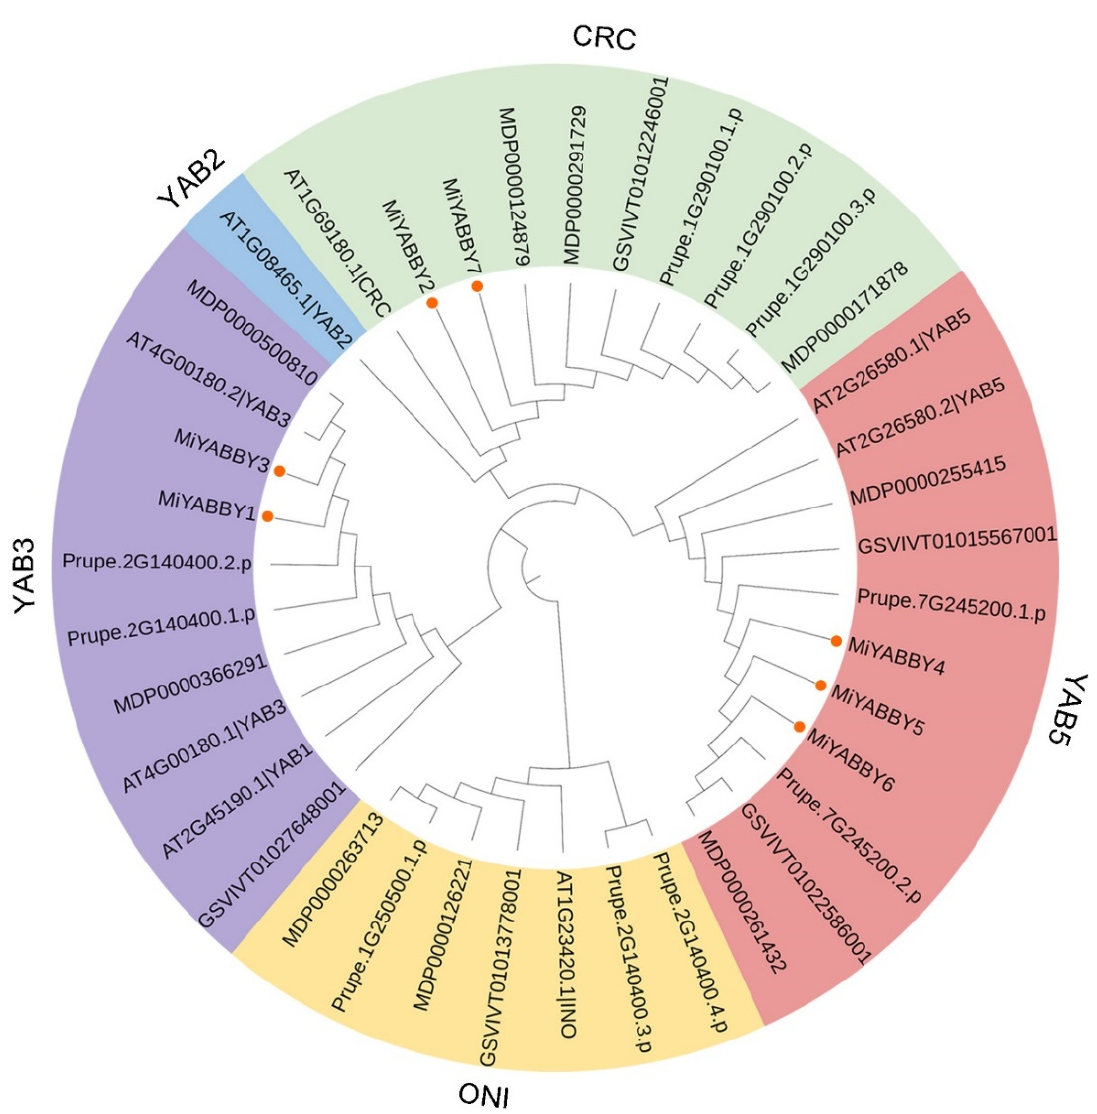
Figure 2. Phylogenetic analysis of the YABBY family in mango, Arabidopsis, apple, grape, and peach. MiYABBY represents mango (with orange dot mark), AT represents Arabidopsis, MDP represents apple, Prupe represents grape, and GSVIVT represents peach.